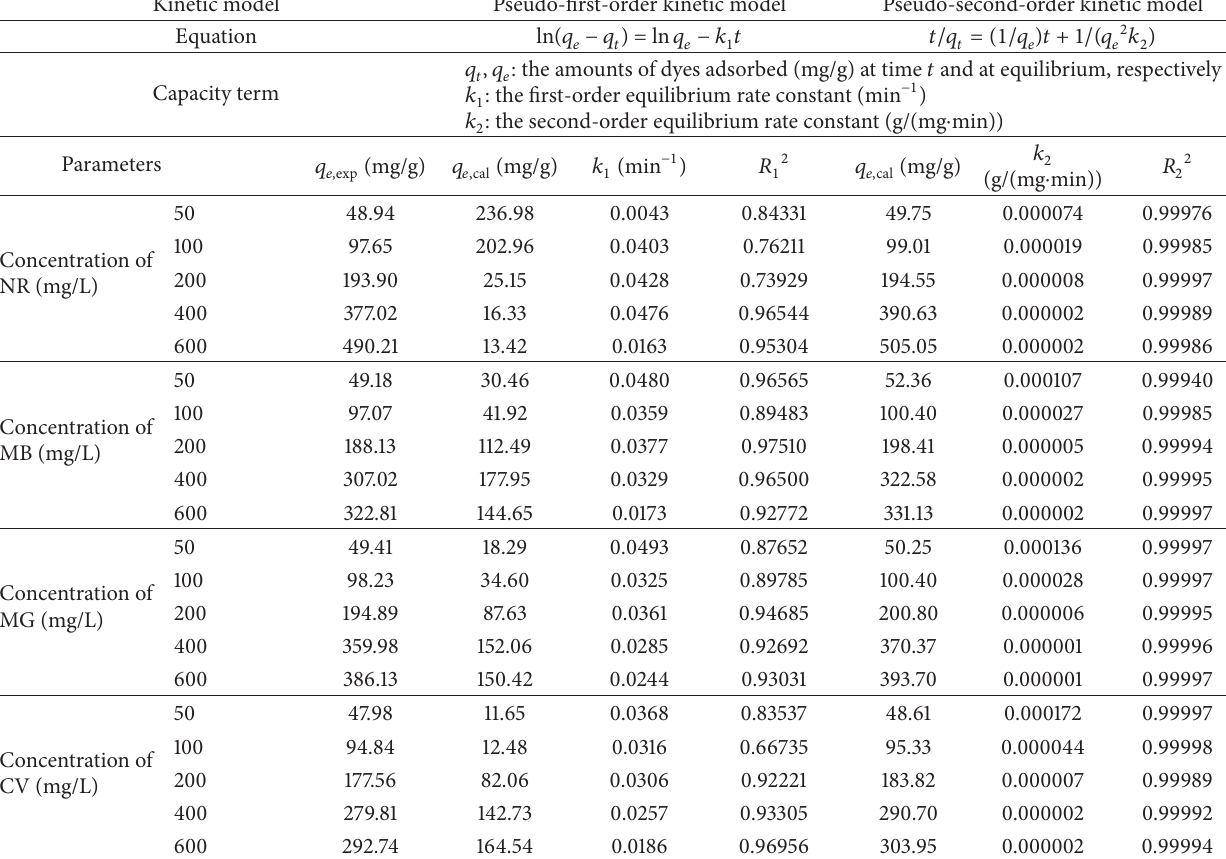
Table 2: Equations and parameters of kinetic models and kinetic parameters of dyes onto TN-TP.